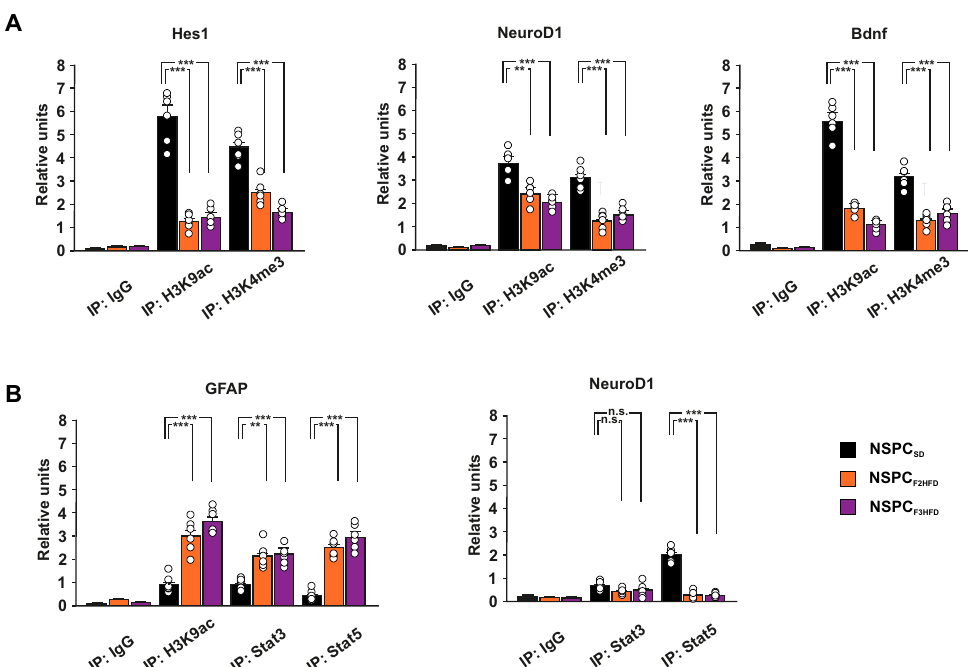
Figure 6. Ancestor HFD induced epigenetic alteration in the promoters of genes regulating adult neurogenesis. ( A ) ChIP assays of H3K9ac and H3K4me3 on the promoters of Hes1, NeuroD1, and Bdnf genes in NSPC SD , NSPC F2HFD and NSPC F3HFD ( n = 6; statistics by one-way ANOVA and Bonferroni post hoc). ( B ) ChIP assays of H3K9ac, STAT3 and STAT5 on the promoter of Gfap, and STAT3/STAT5 on the promoter of NeuroD1 in NSPC SD , NSPC F2HFD and NSPC F3HFD . ( n = 6; statistics by one-way ANOVA and Bonferroni post hoc). IgG are used as negative controls. Real-time analysis was performed in triplicate. Data are expressed as mean ± SEM. ** p < 0.01; *** p < 0.001; n.s. is not significant.